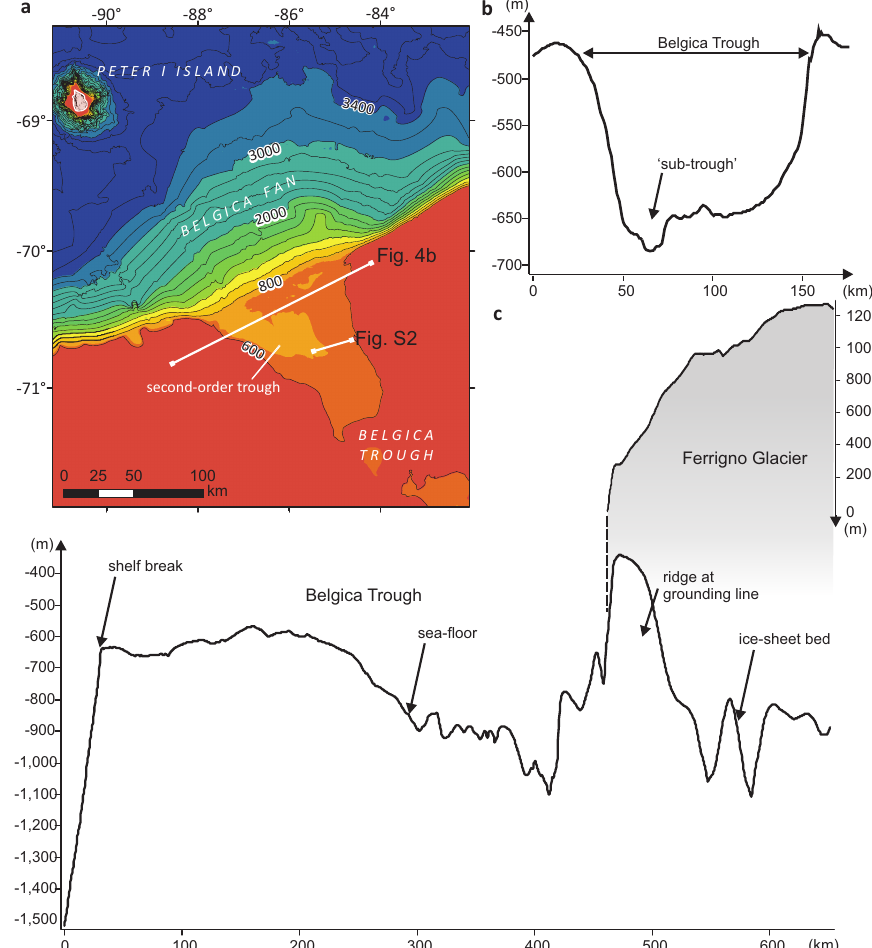
Fig. 4. (a) Bathymetry of the outer shelf near the mouth of Belgica Trough, showing the small second order sub-trough, the shelf edge, and the Belgica Fan; contours at 200m intervals. (b) Cross-profile extracted from the new grid across the mouth of Belgica Trough; location shown in Fig. 4a. (c) Along-trough profile of the Belgica Trough and the Ferrigno Glacier basal topography, extracted from the new topographic grid. Note the unusual morphology of the outer shelf, and the apparent ridge at the glacier grounding line. Surface elevations of Ferrigno Glacier taken from the RadarSat DEM. For location, see Fig.